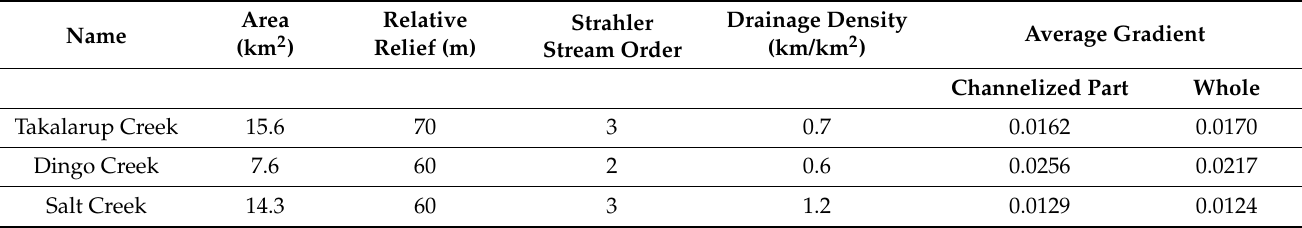
Table 1. Details of the three study